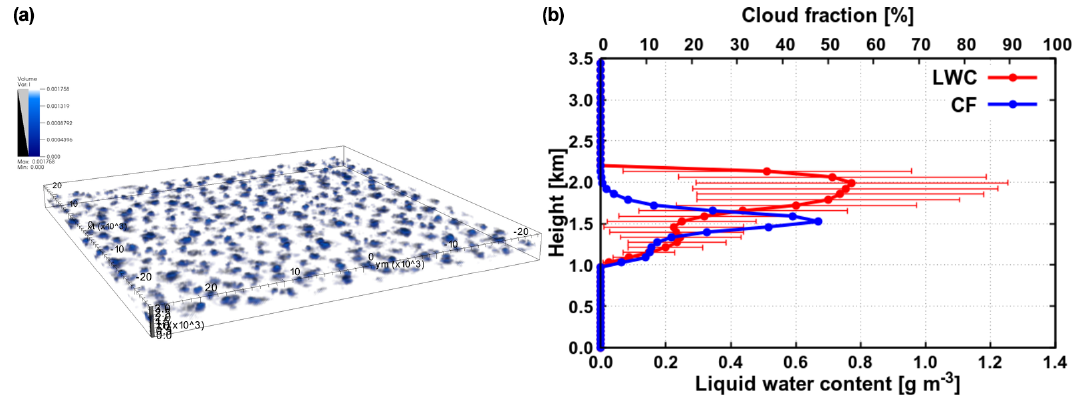
Figure 2. (a) Shallow cumulus cloud field used as input for radiative transfer calculations (visualization with VisIt; Childs et al., 2012). (b) Averaged LWC, its standard deviation (marked with error bars) and cloud fraction.